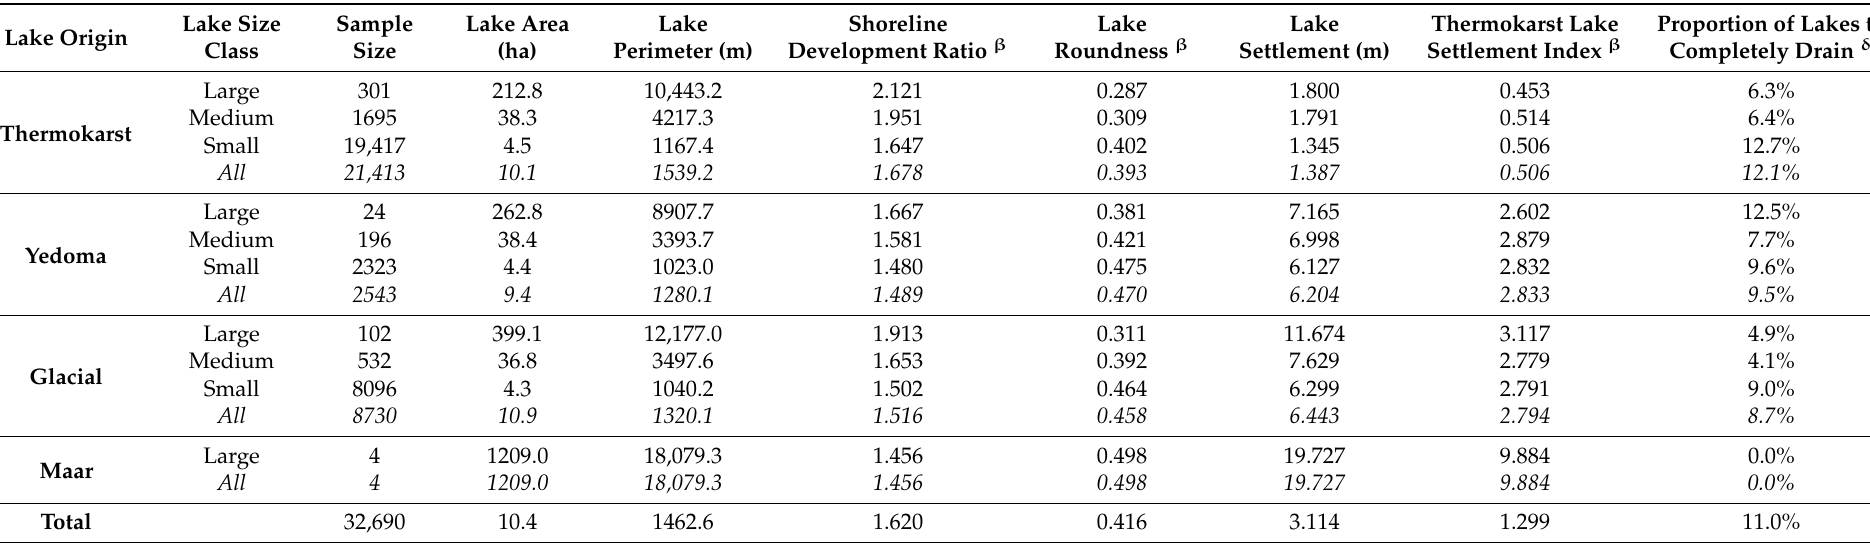
Table 2. Summary of lake morphological metrics and lake drainage corresponding to lake origin (Thermokarst, Yedoma, Glacial, and Maar lakes) spanning all lakes in our northern Alaska spatial